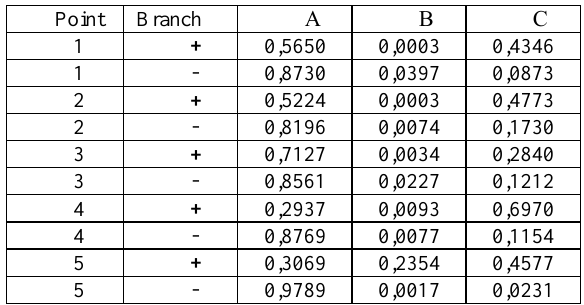
Table 3. The coefficients of the approximation curve for points across the step surface. Sign of the branches corresponds to the sign of the probe potential